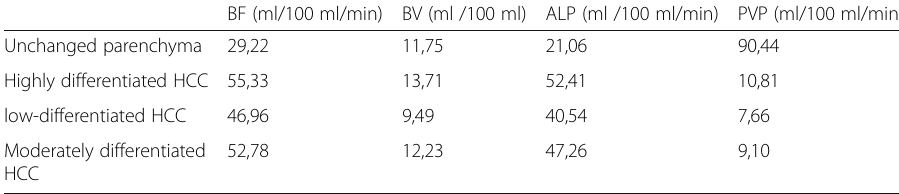
Table 3 Perfusion mean values in tumor nodes and in normal hepatic parenchyma